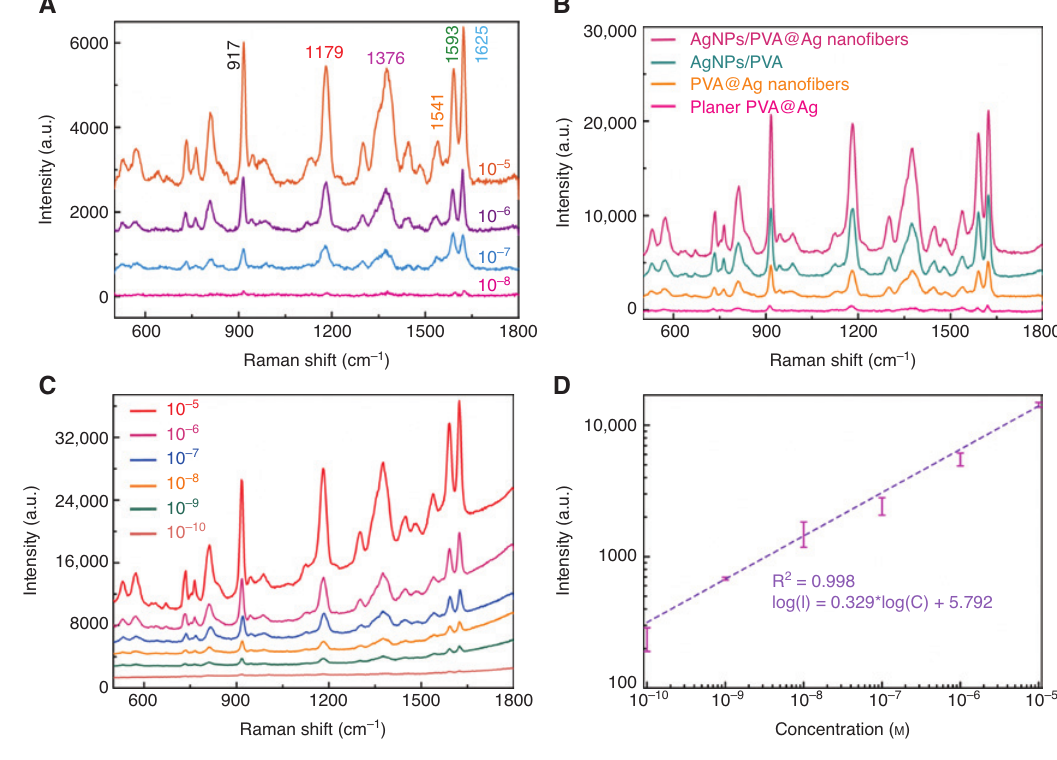
Figure 5: SERS performance on different substrates. (A) SERS spectra of CV with concentrations from 10 −5 to 10 −8 m on the PVA@Ag nanofibers substrate. (B) Raman spectra of CV molecules (10 −5 m) detected on AgNPs/PVA@Ag nanofibers, AgNPs/PVA, electrospunning PVA@Ag nanofibers and planar PVA@Ag sample. (C) SERS spectra of CV with concentrations from 10 −5 to 10 −10 m on the AgNPs/PVA@Ag nanofibers substrate. (D) Linear relationships (R 2 = 0.998): Raman intensities at 914 cm −1 as a function of the concentrations of CV molecules on the AgNPs/PVA@Ag nanofibers